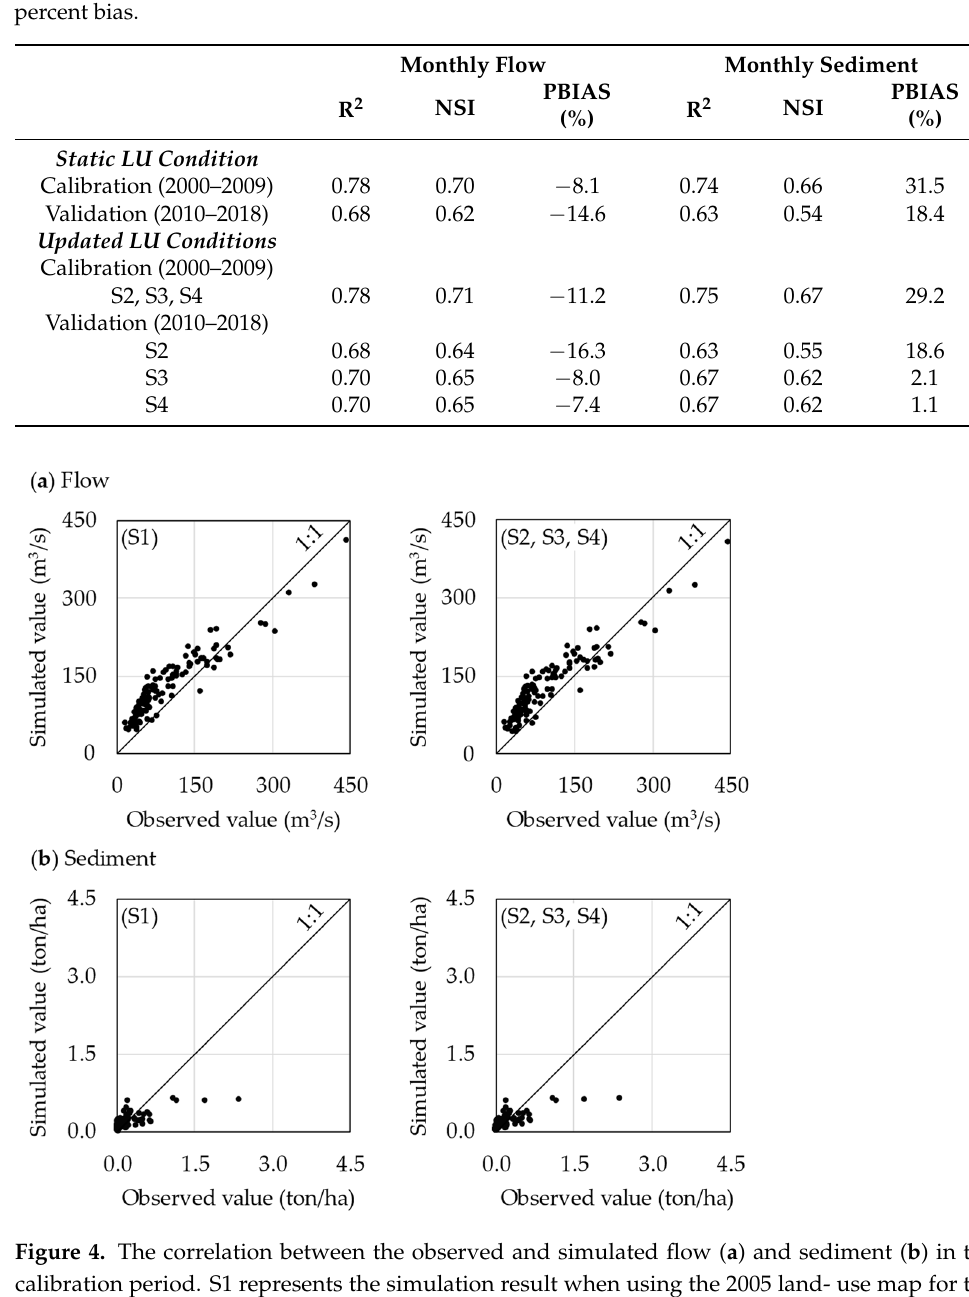
Figure 4. The correlation between the observed and simulated flow ( a ) and sediment ( b ) in the calibration period. S1 represents the simulation result when using the 2005 land- use map for the entire calibration period. S2, S3, and S4 represent the simulation results when using the two land- use condition types: namely, the 2005 land-use map from 2000 to 2004, and the linearly interpolated map for the 2010 land- use condition during the calibration period.